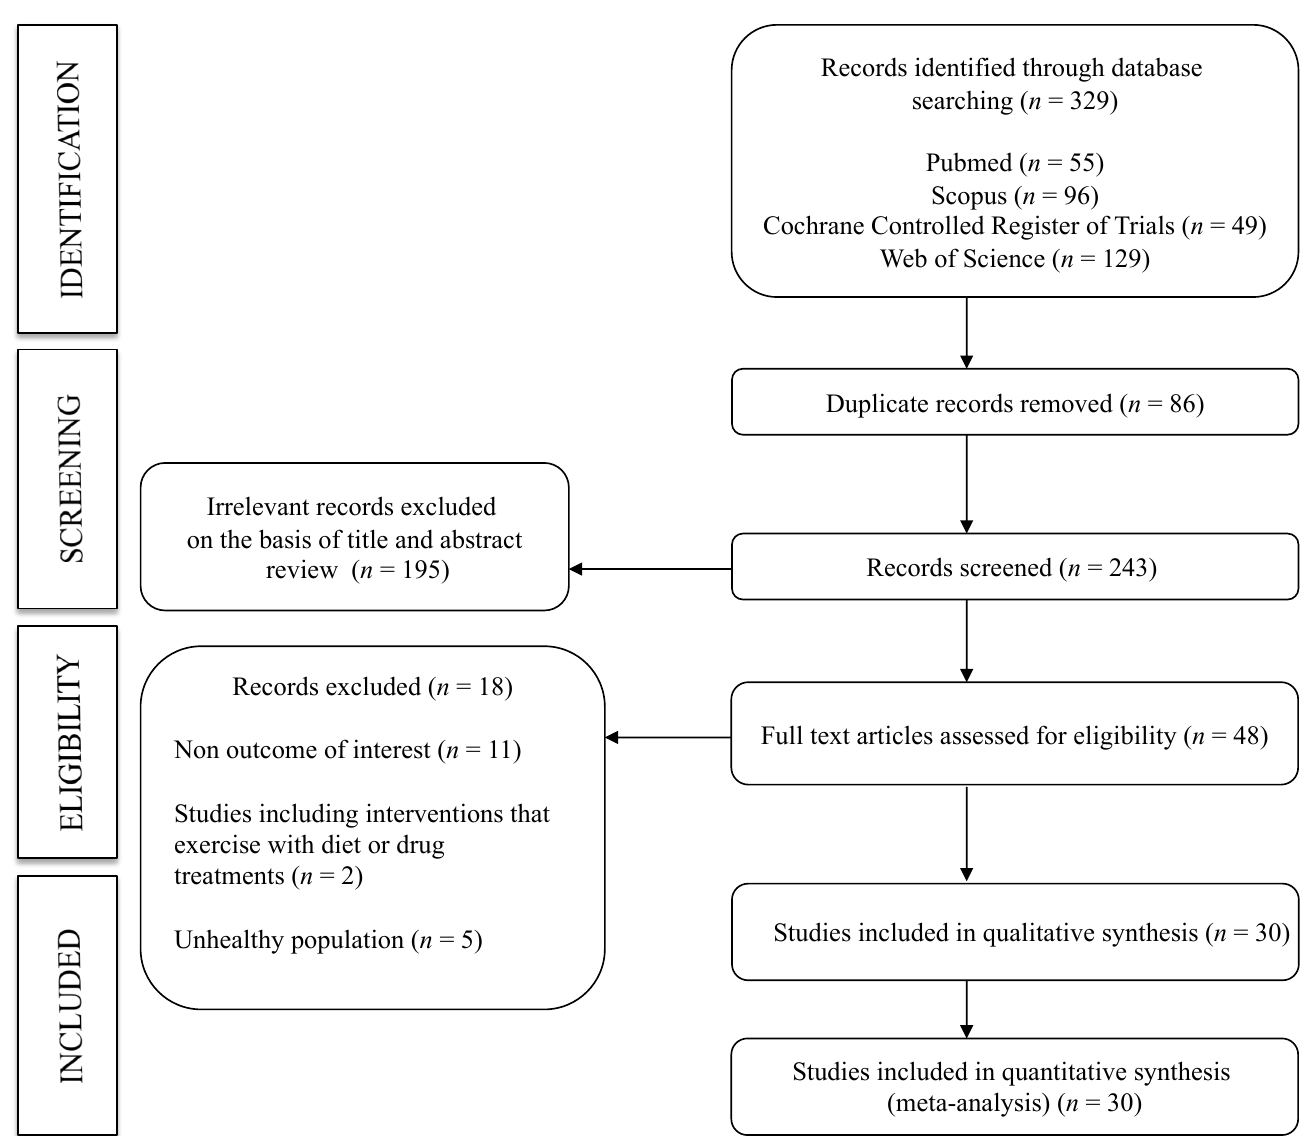
Figure 1. Flowchart: search